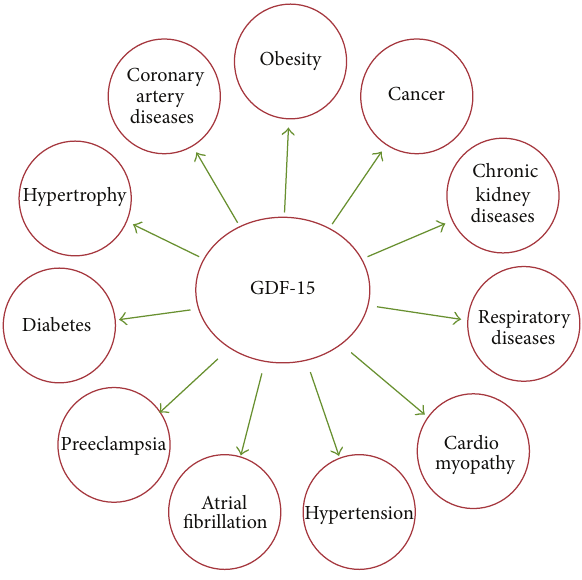
Figure 1: Role of GDF-15 in different diseases conditions. GDF- 15 plays an important role to modulate metabolic, cardiovascular, obesity, cancer, and chronic